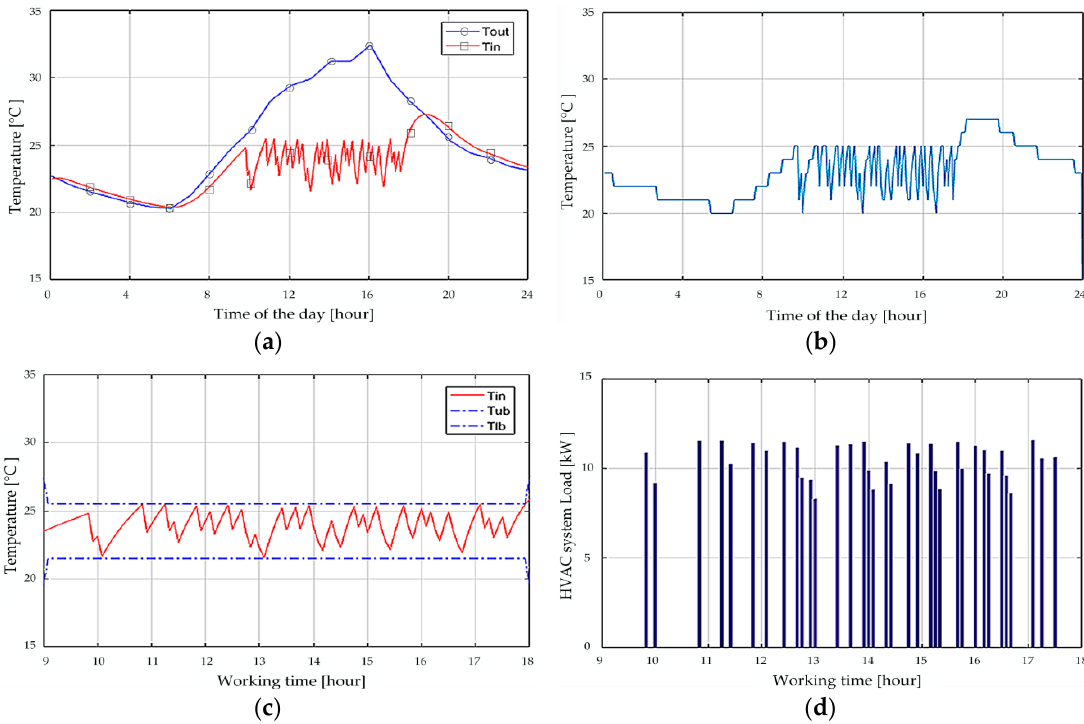
Figure 7. Case 2 simulation results. ( a ) Outdoor temperature and room temperature; ( b ) setting temperature; ( c ) indoor temperature and constraints range (work time); ( d ) HVAC system power (work time). Table 5. Summary of Case 2 simulation results.